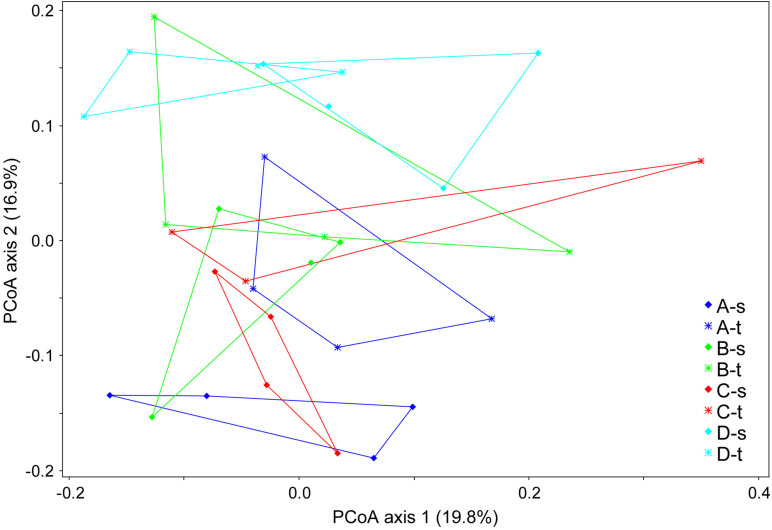
Community clustering of the mycobiome of tolerant (t) and susceptible (s) ashes from the four forest districts (A–D). A principle coordinate analysis (PCoA) was applied based on a Bray-Curtis distance matrix.